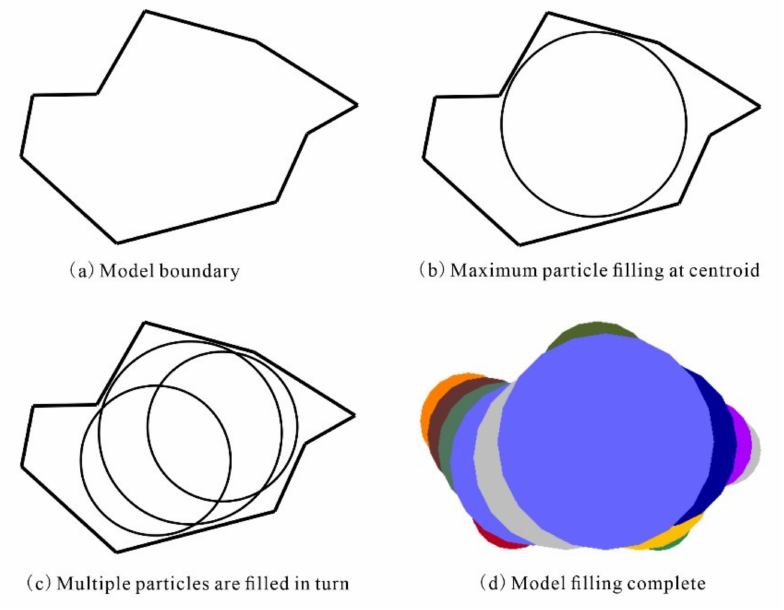
Figure 1. The filling process of the clump